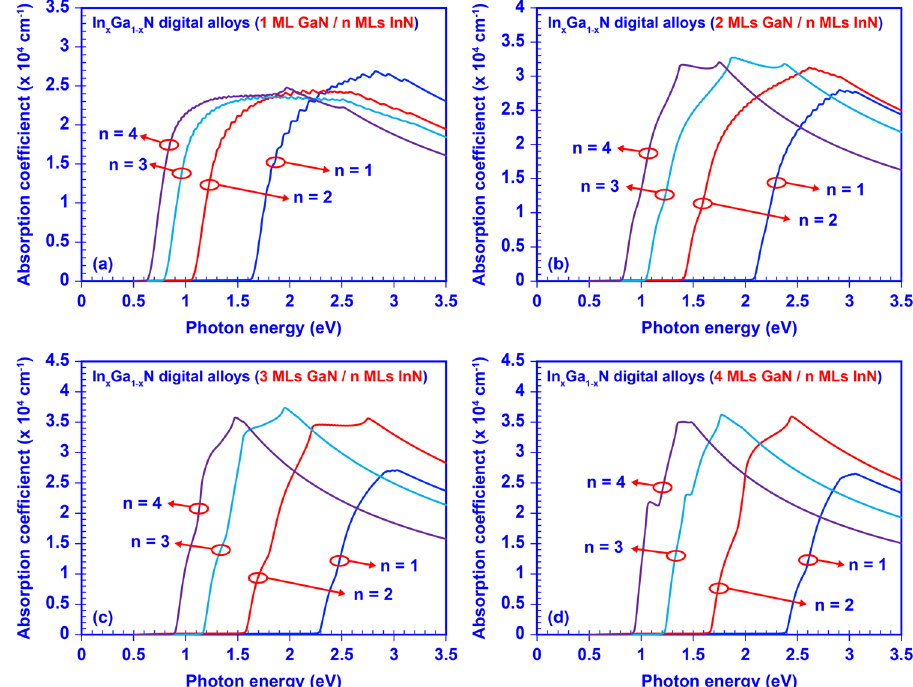
Figure 5. Absorption spectra of the 50-periods InGaN digital alloys: set ( a ) 1 ML GaN with 1, 2, 3, 4 MLs InN, respectively; set ( b ) 2 MLs GaN with 1, 2, 3, 4 MLs InN, respectively; set ( c ) 3 MLs GaN with 1, 2, 3, 4 MLs InN, respectively; and set ( d ) 4 MLs GaN with 1, 2, 3, 4 MLs InN,